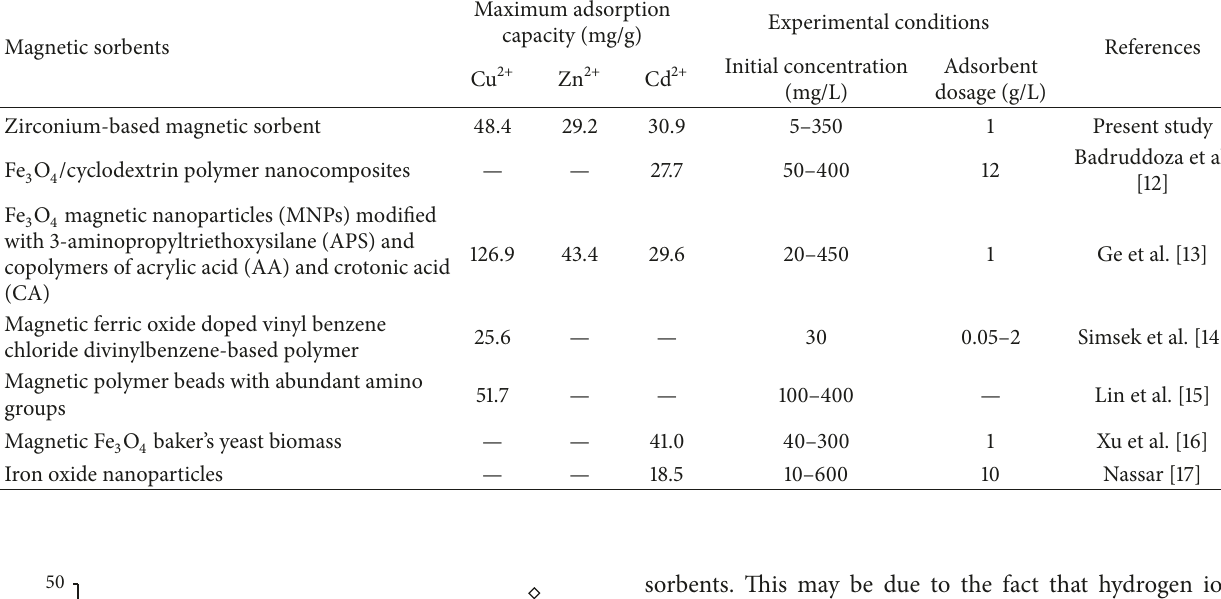
Table 1: Comparison of maximum adsorption capacity of the zirconium-based ferromagnetic sorbent with various magnetic sorbents reported in literatures for Cu 2+ , Zn 2+ , and Cd 2+ adsorption.